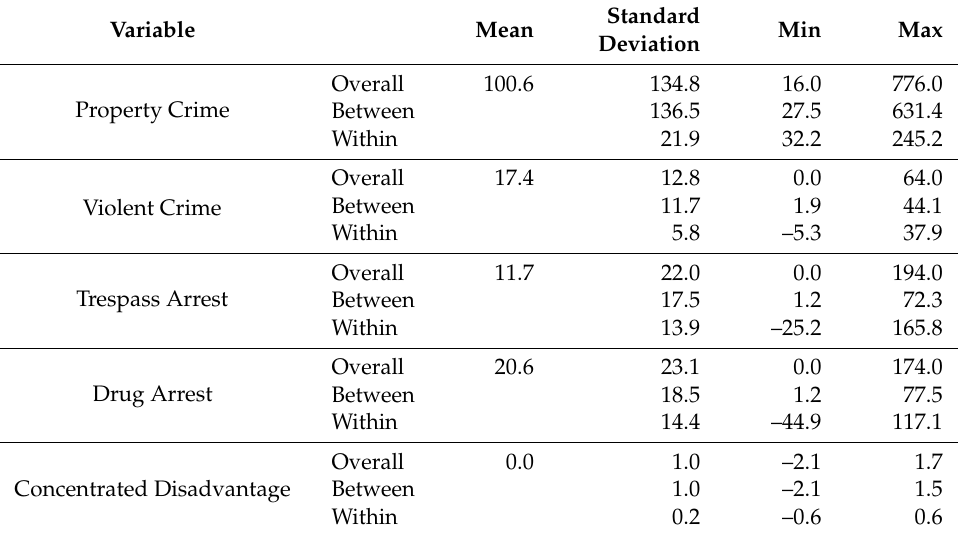
Table 2. Summary